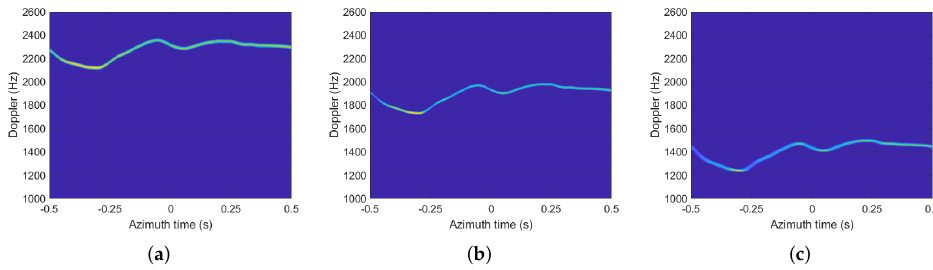
Figure 8. Morlet wavelet transform of the azimuth signal: ( a ) point A; ( b ) point B; ( c ) point C.